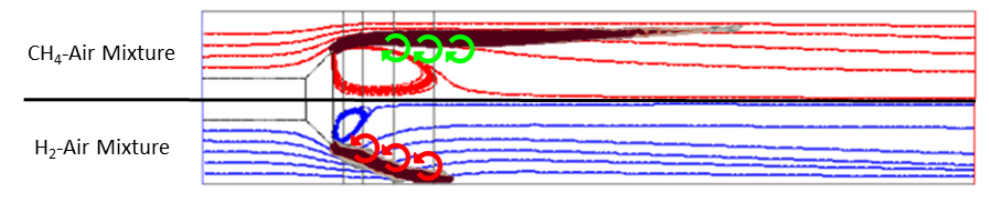
Figure 3. Schematic view of vortical structures downstream from the bluff body for the two different fuel